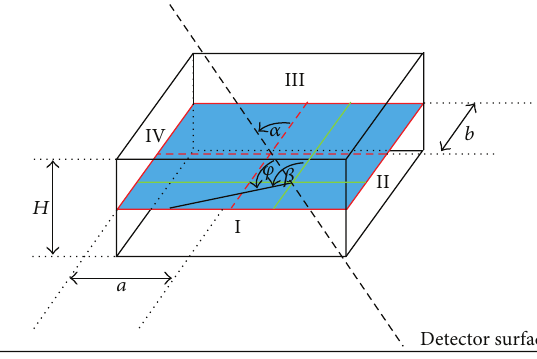
Figure 2: Schematic diagram of a parallelepiped source.